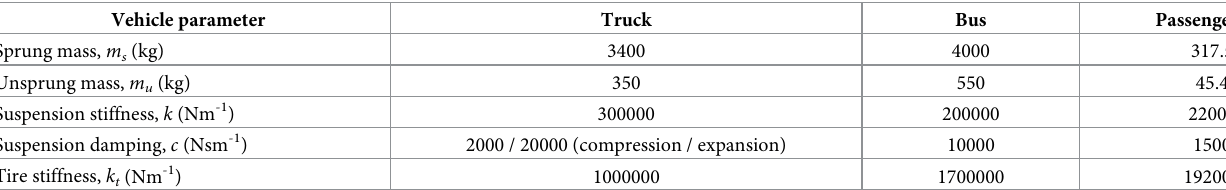
Table 1. The quarter vehicle parameter values of a truck and a bus with a typical passenger car as comparison.